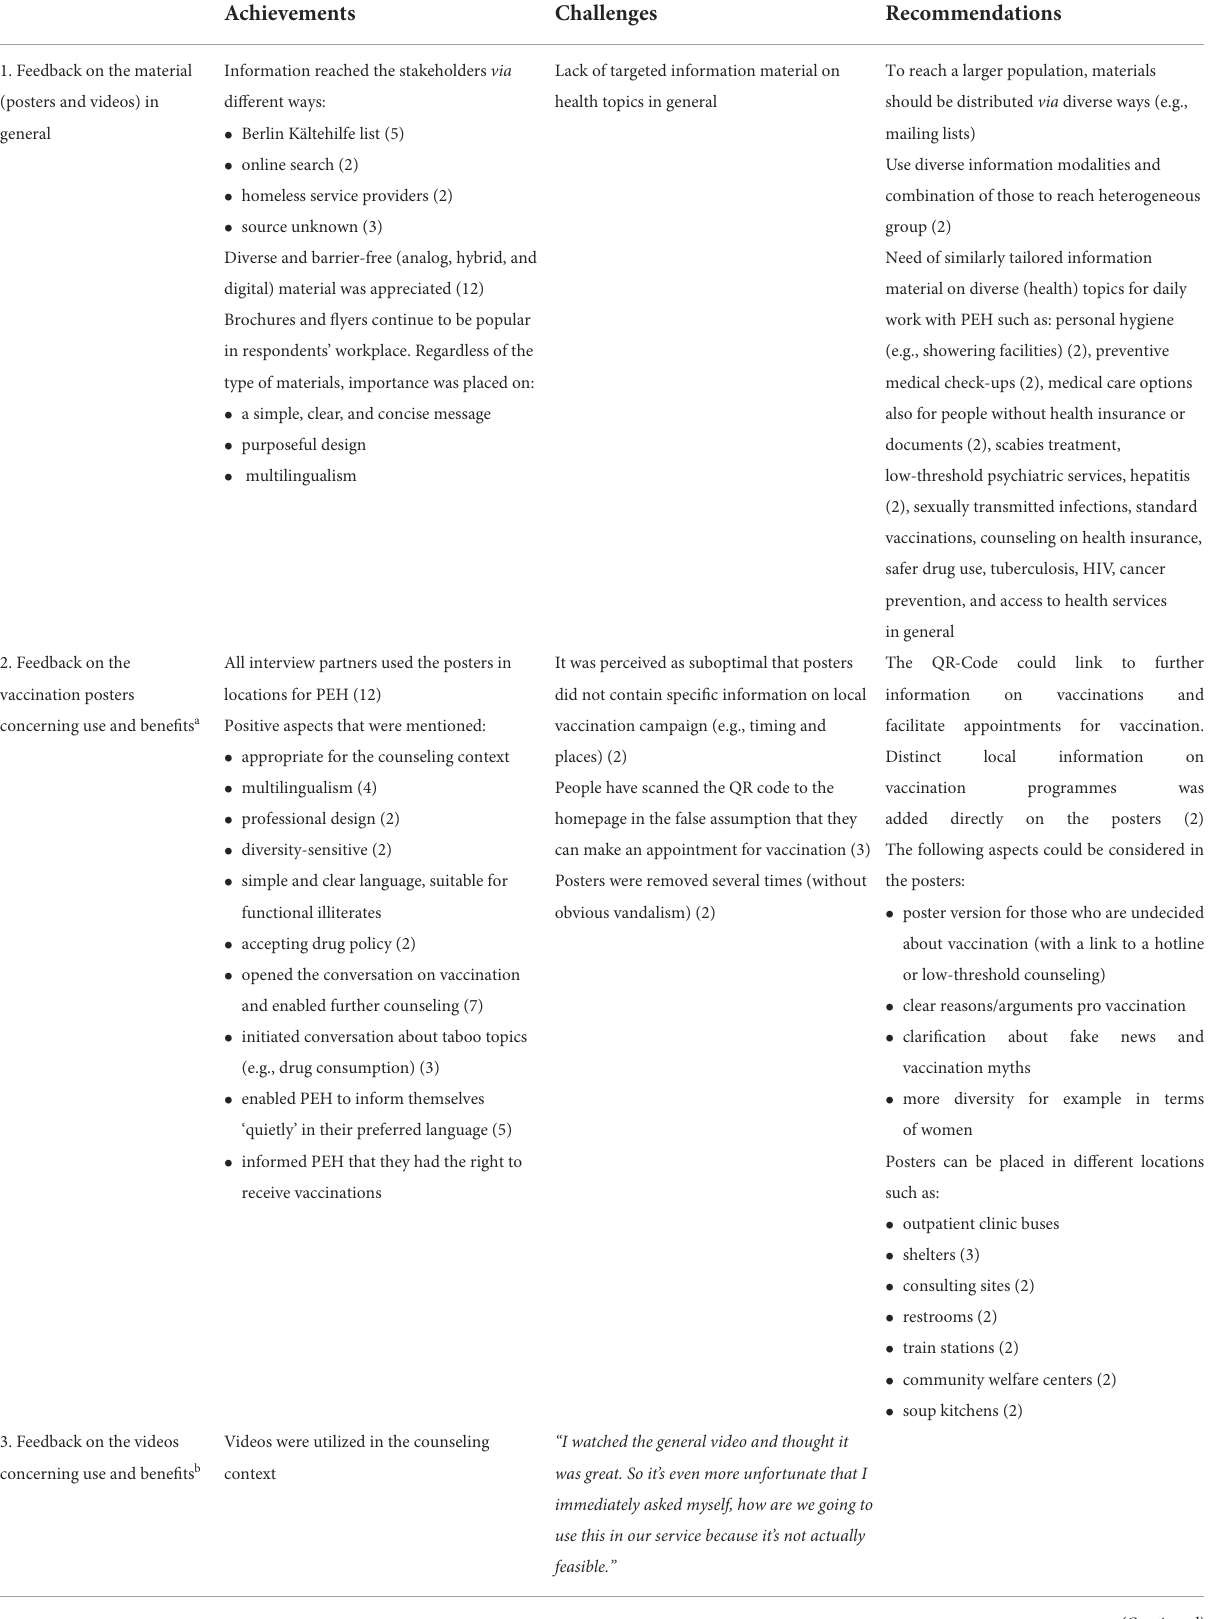
TABLE 1 Evaluation of the videos and posters according to semi-structured telephone interviews with 12 institutions. Achievements